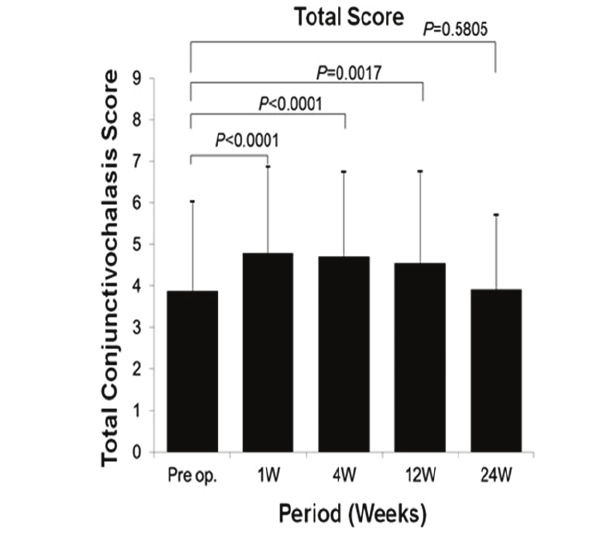
Figure 1. Mean postoperative total conjunctivochalasis score at each time